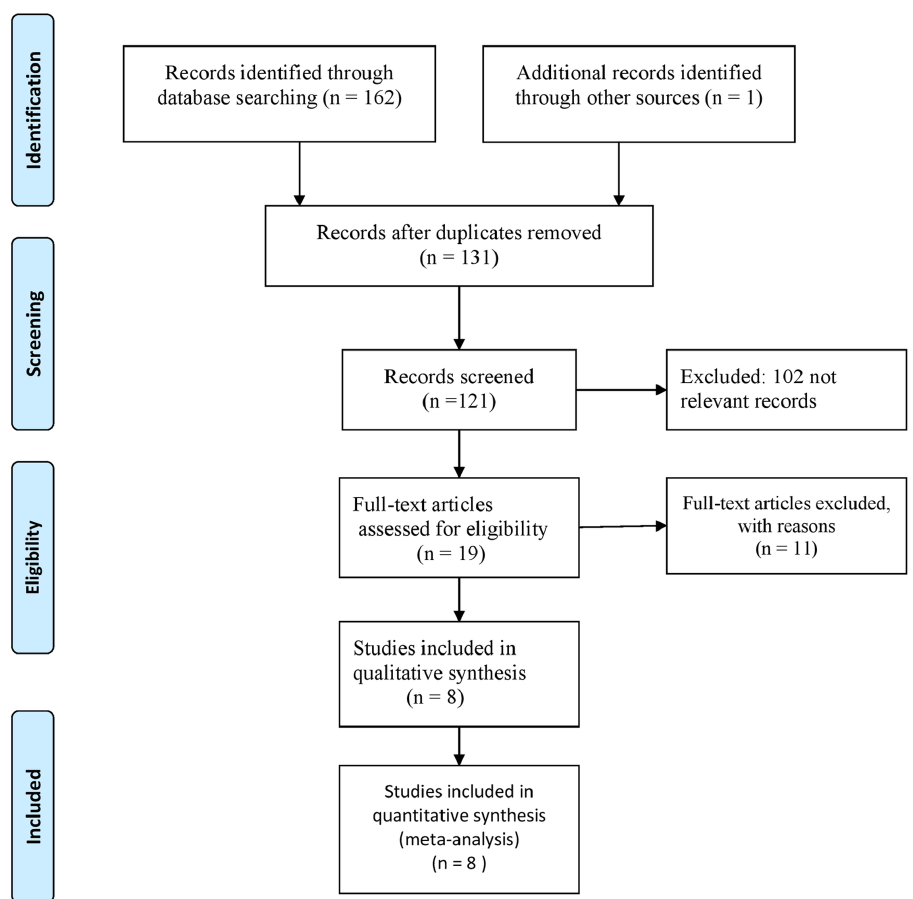
Fig 1. PRISMA flow diagram showing the study selection